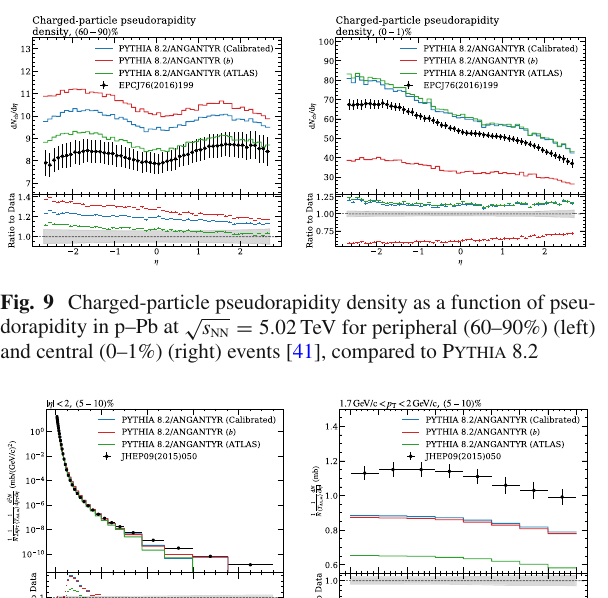
√ = 2 . 76TeV, in s NN